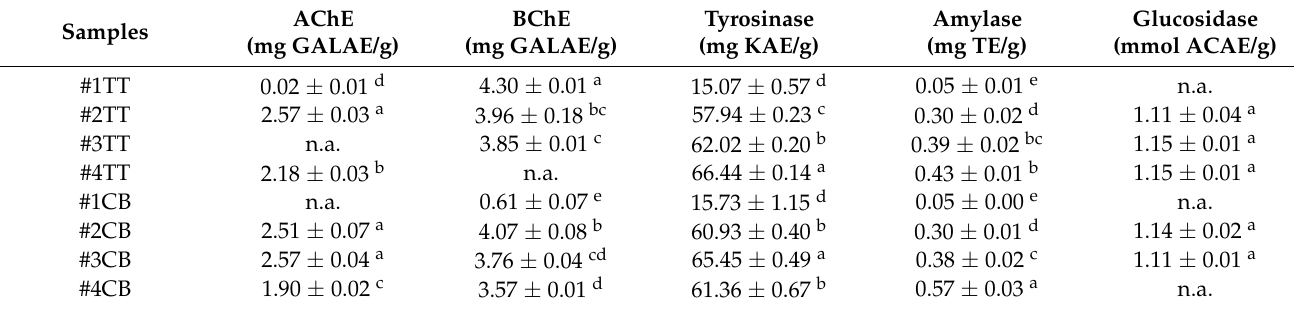
Table 4. Enzymatic inhibition of the tested